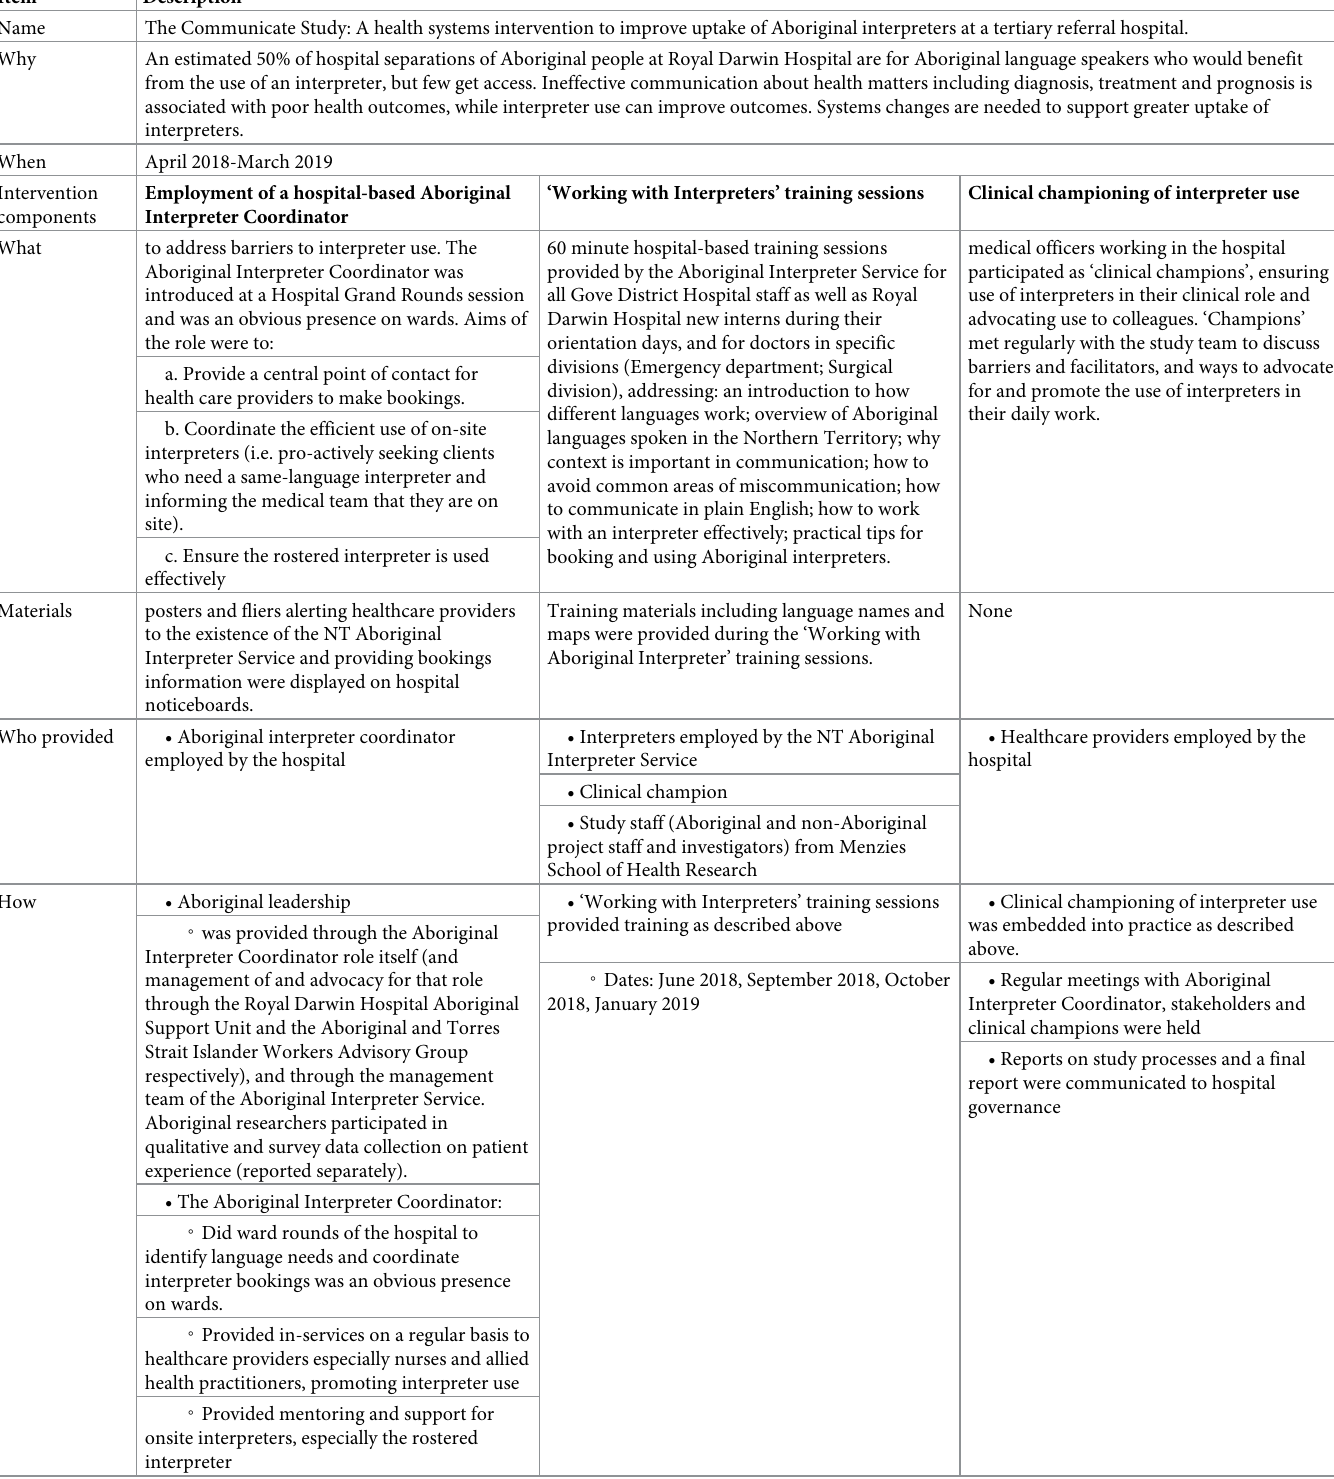
Table 2. Description of study intervention activities according to the template for intervention description and replication (TIDieR)